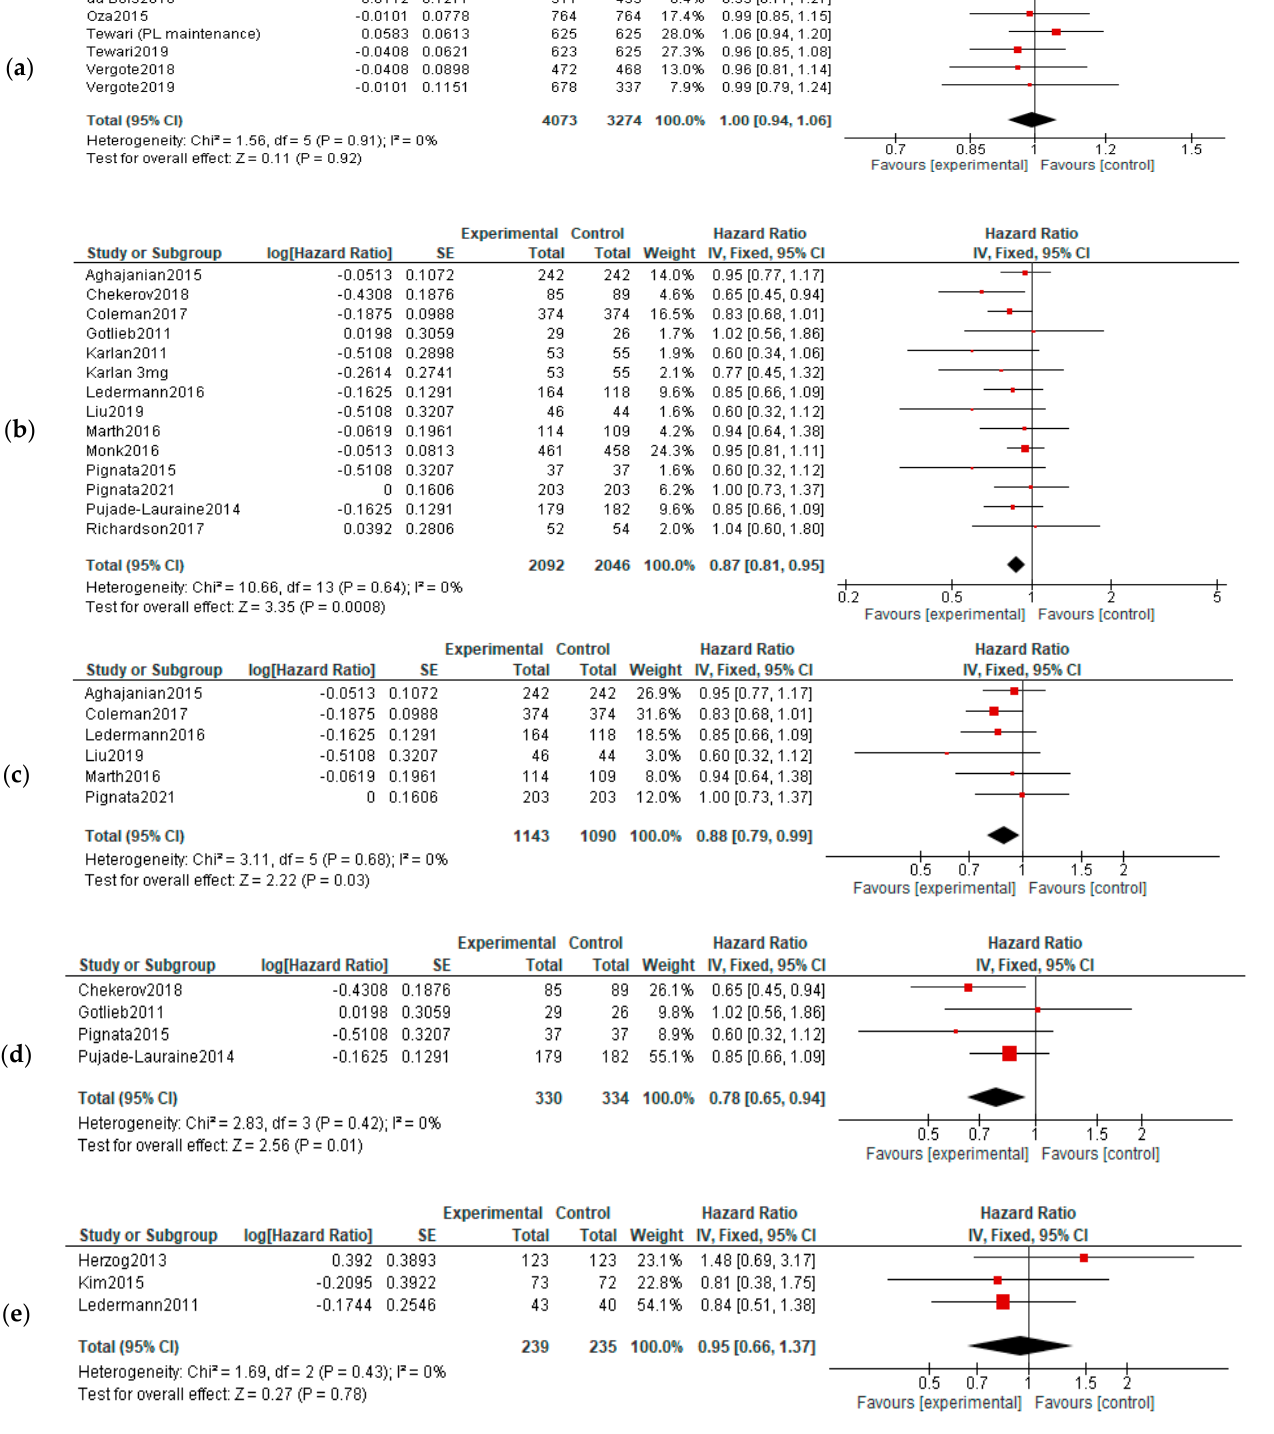
Figure 4. Settings subgroup analysis of overall survival: ( a ) first line, ( b ) recurrent, ( c ) P-S R, ( d ) P-R R and ( e ) maintenance. The black diamonds are visual representations of the pooled effect and its confidence intervals and are non-significant if they overlap 1. Red squares represent each study effect size and study weight size of square). The lines represent each study confidence interval.